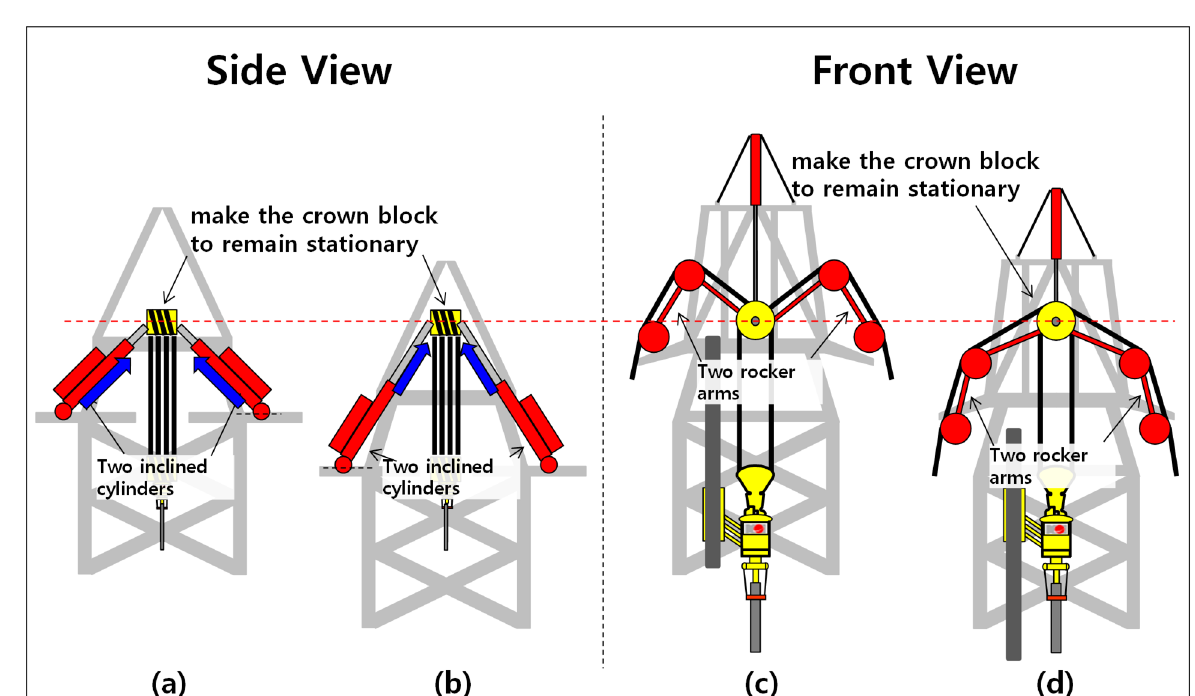
Figure 6. The operating mechanism of the drill string compensator.